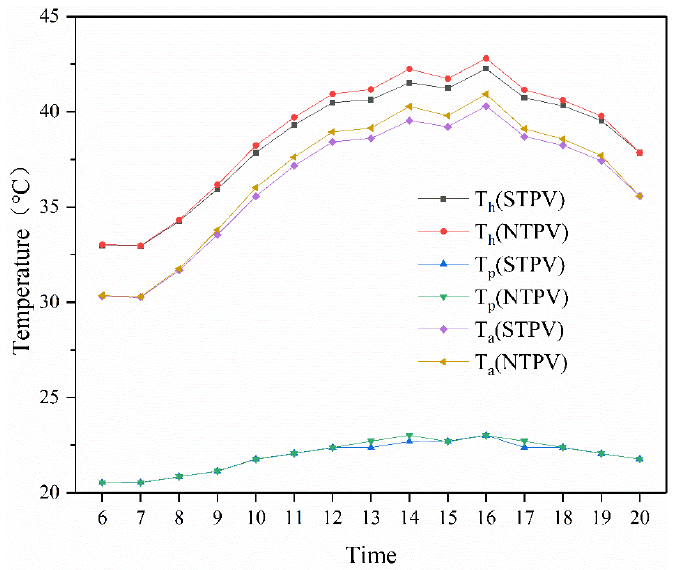
Figure 9. Temperature of different components under two types of component power generation.